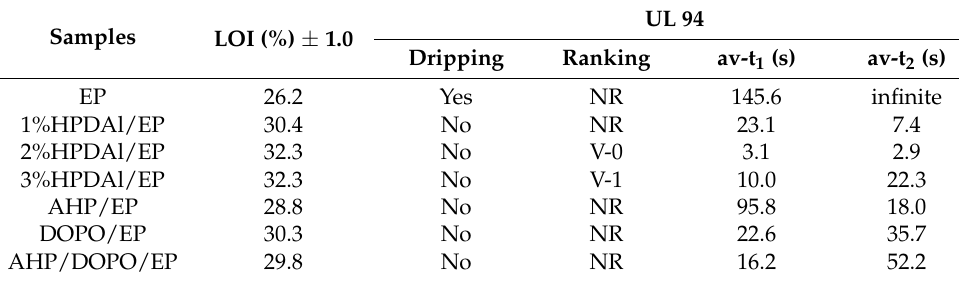
Table 1. Flammability of flame-retardant epoxy